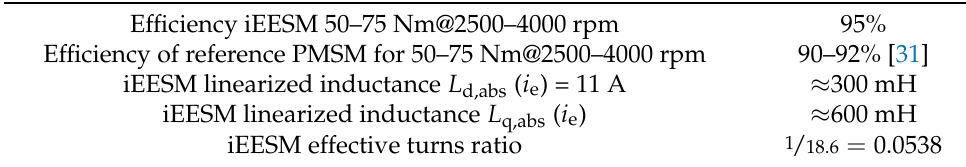
Table 3. Measurement results.